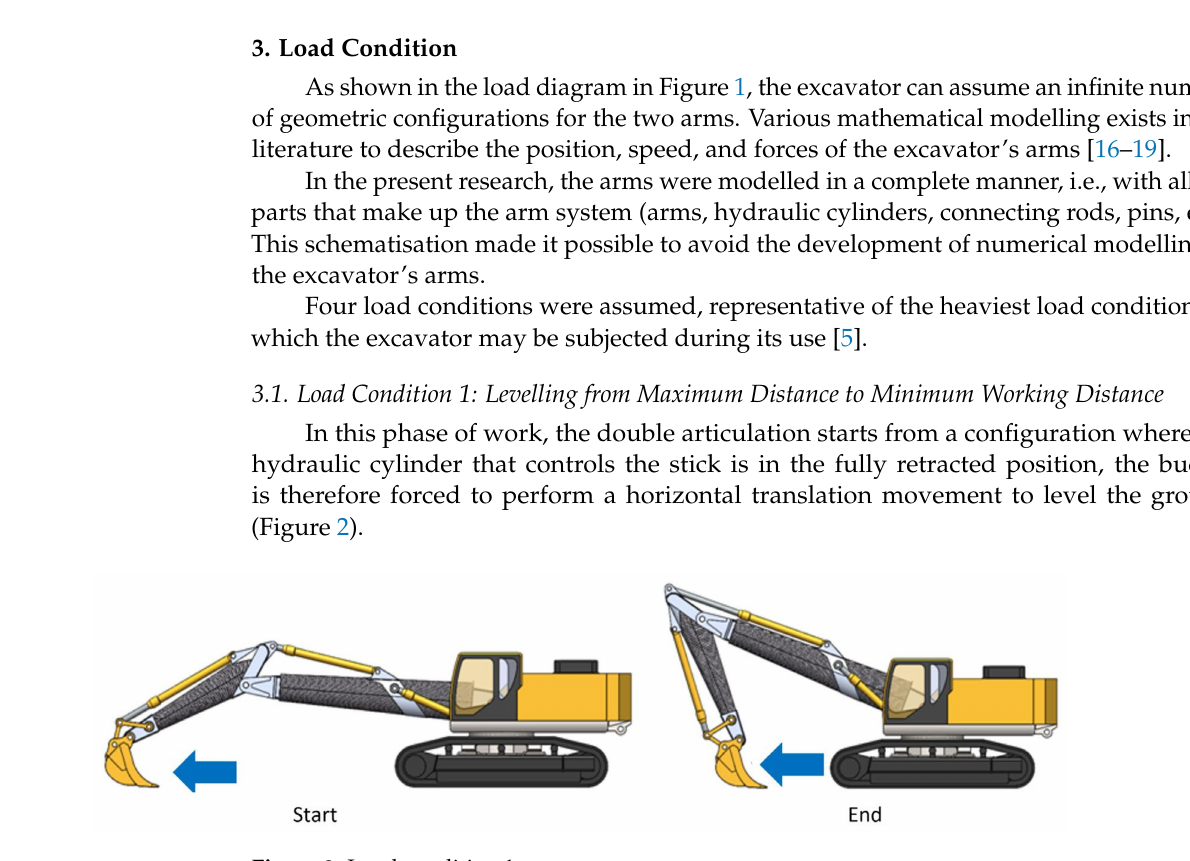
Figure 2. Load condition